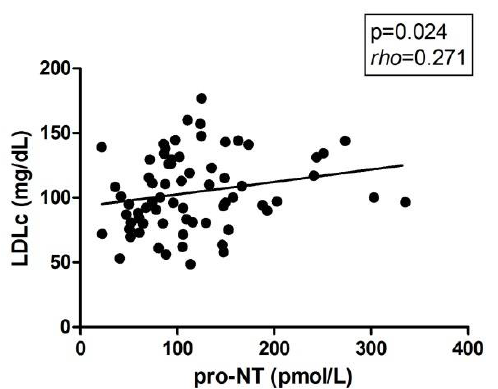
Figure 3. Correlation between plasma pro-NT and LDLc levels. Pro-NT, pro-neurotensin; LDLc, low-density lipoprotein cholesterol. p < 0.05 is considered statistically significant.